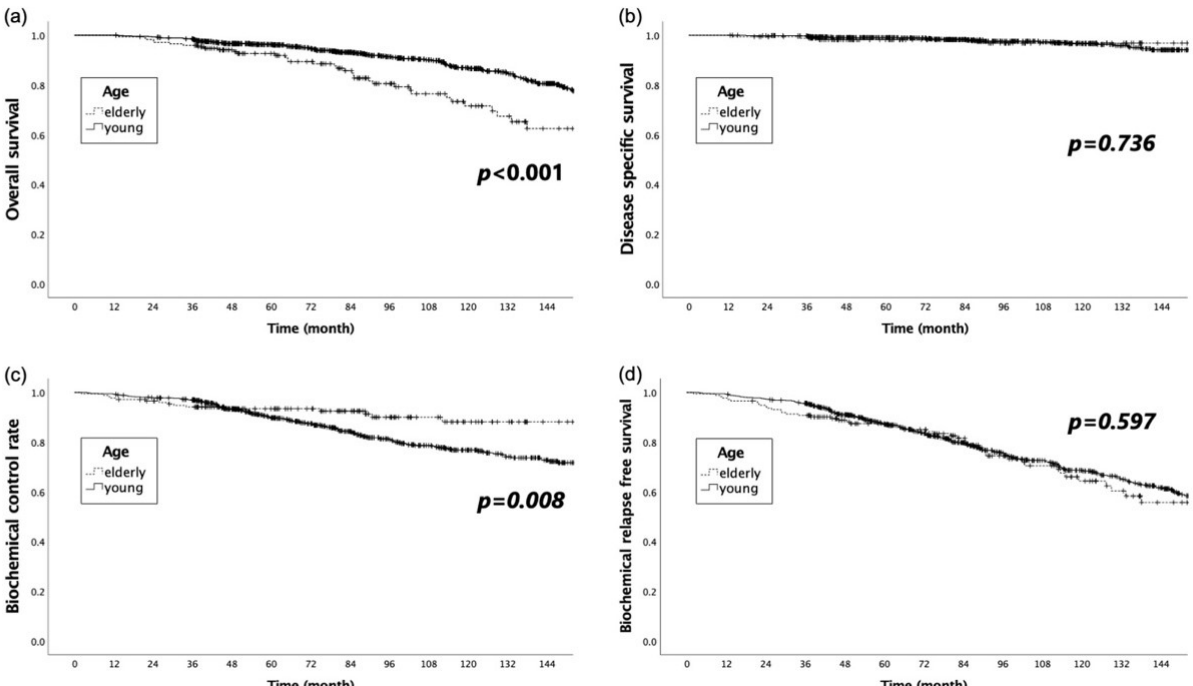
Figure 2. Comparison of the Kaplan–Meier curves for ( a ) overall survival, ( b ) disease-specific survival, ( c ) biochemical recurrence control rate, and ( d ) biochemical relapse-free survival for the young and elderly groups .